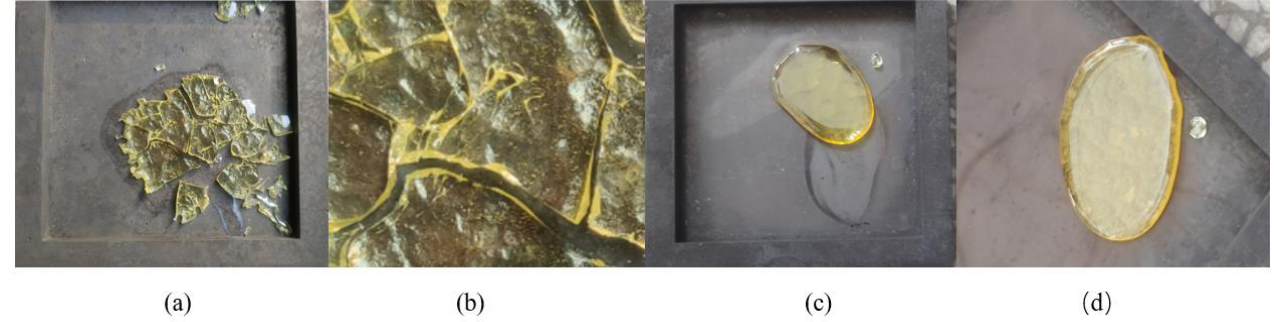
Figure 3. TPB-0 ( a and b ), TPB-1 ( c ), and TPB-5 ( d ) glass samples after casting. Table 1. Compositions, density, and thickness of glass sample